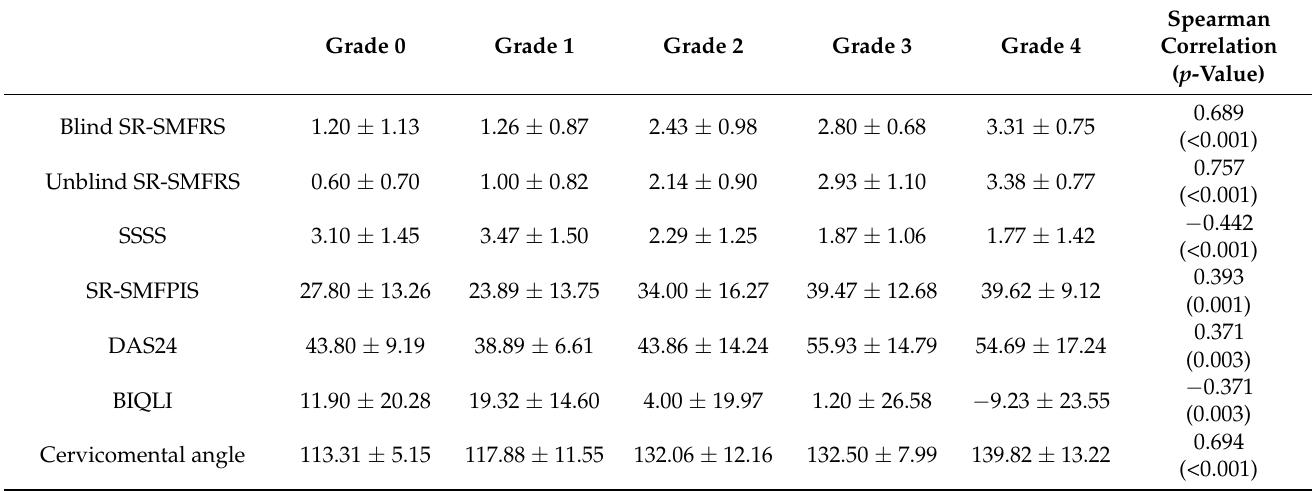
Table 4. Correlation of ER-SMFRS with blind SR_SMFRS, unblind SR-SMFRS, SSSS, SR-SMFPIS, DAS24, BIQLI, and cervicomental angle.